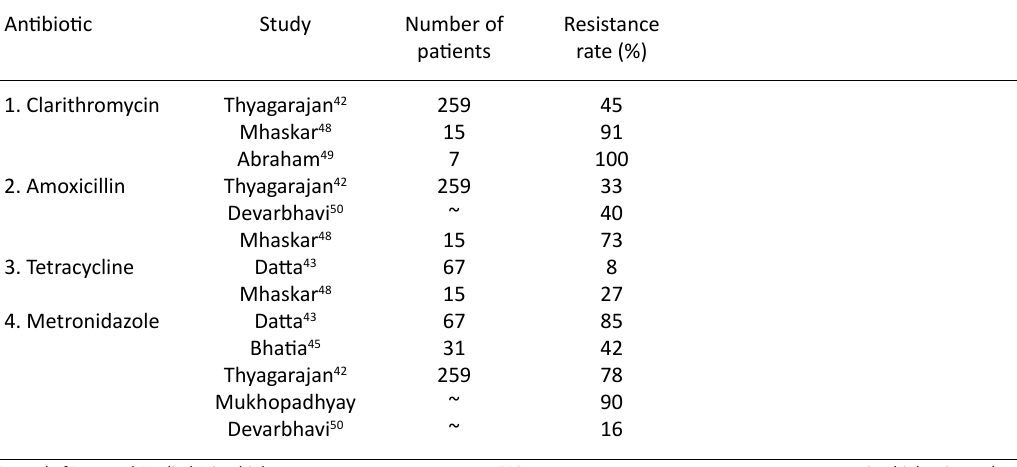
Table 1. H. pylori antibiotic resistance in India Antibiotic Study Number of Resistance patients rate (%)